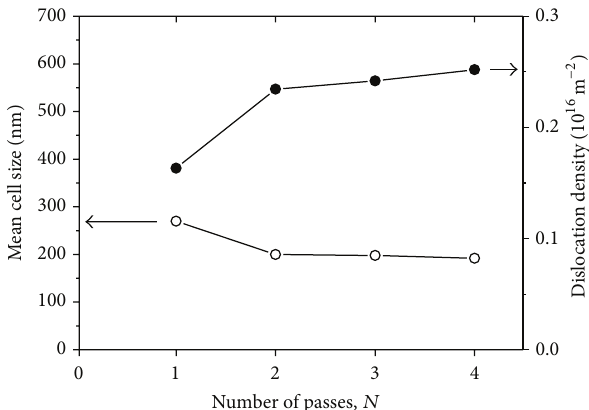
Figure 2: The cell size and the dislocation density evolutions during ECAP.